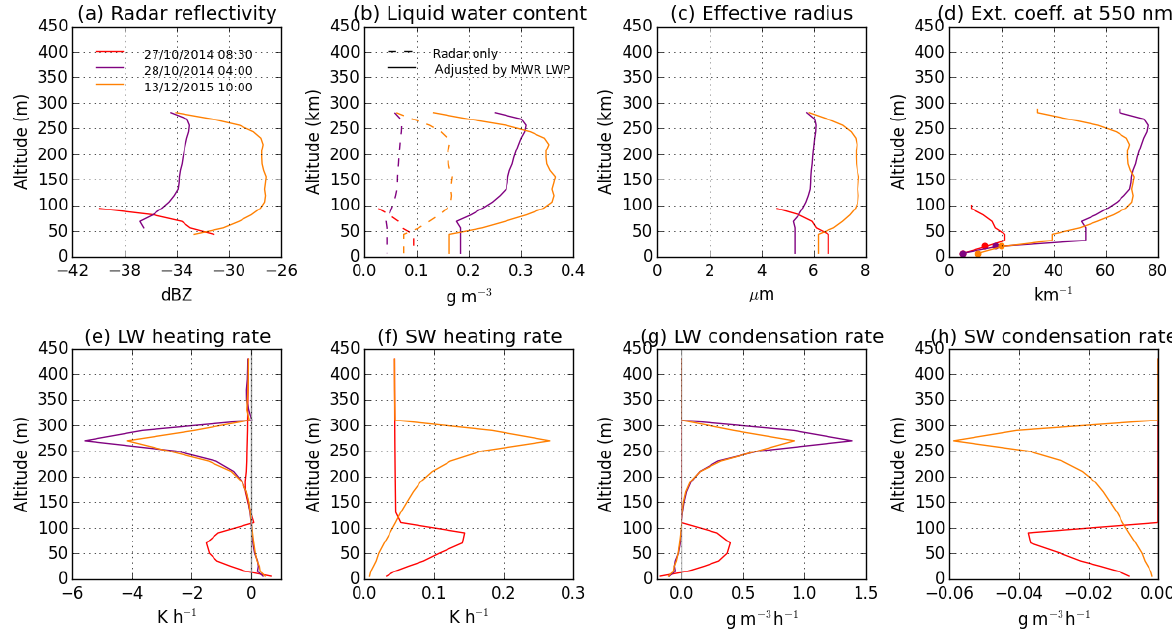
Figure B1. For three different observed fog profiles, vertical profile of (a) 10min mean radar reflectivity; (b) LWC estimated with Eq. (8) before and after normalisation with the MWR LWP (normalisation not performed for red line, as LWP < 10gm − 2 ) ; (c) r eff estimated from Eq. (9); (d) visible extinction coefficient estimated from Eq. (6) (above 30m) and from Eq. (10) (below 30m; circles indicate estimates from the visibility metres); (e–f) radiative heating rate calculated from LW and SW radiation, and (g–h) the subsequently calculated condensation rates with Eq. (5). The solar zenith angle is similar in the two daytime